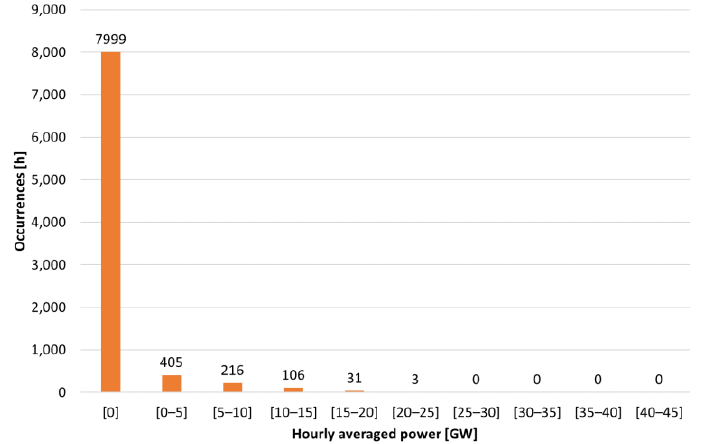
Figure 14. Distribution of hourly averaged power over the year of surplus users in Case 1.